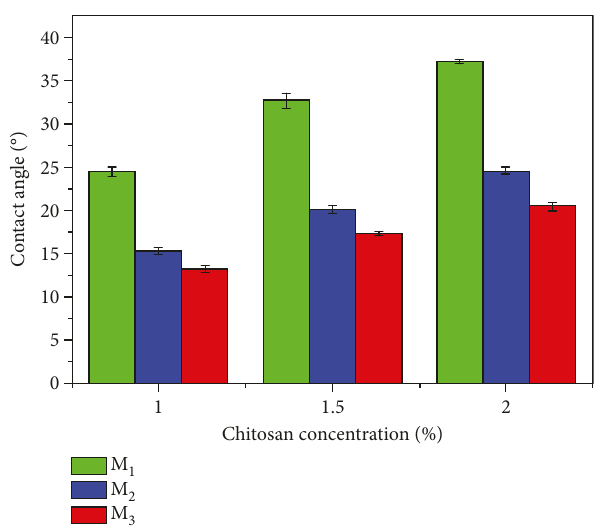
Figure 5: The contact angle of chitosan solution in different concentration. Effect of the DD on the viscosity of chitosan